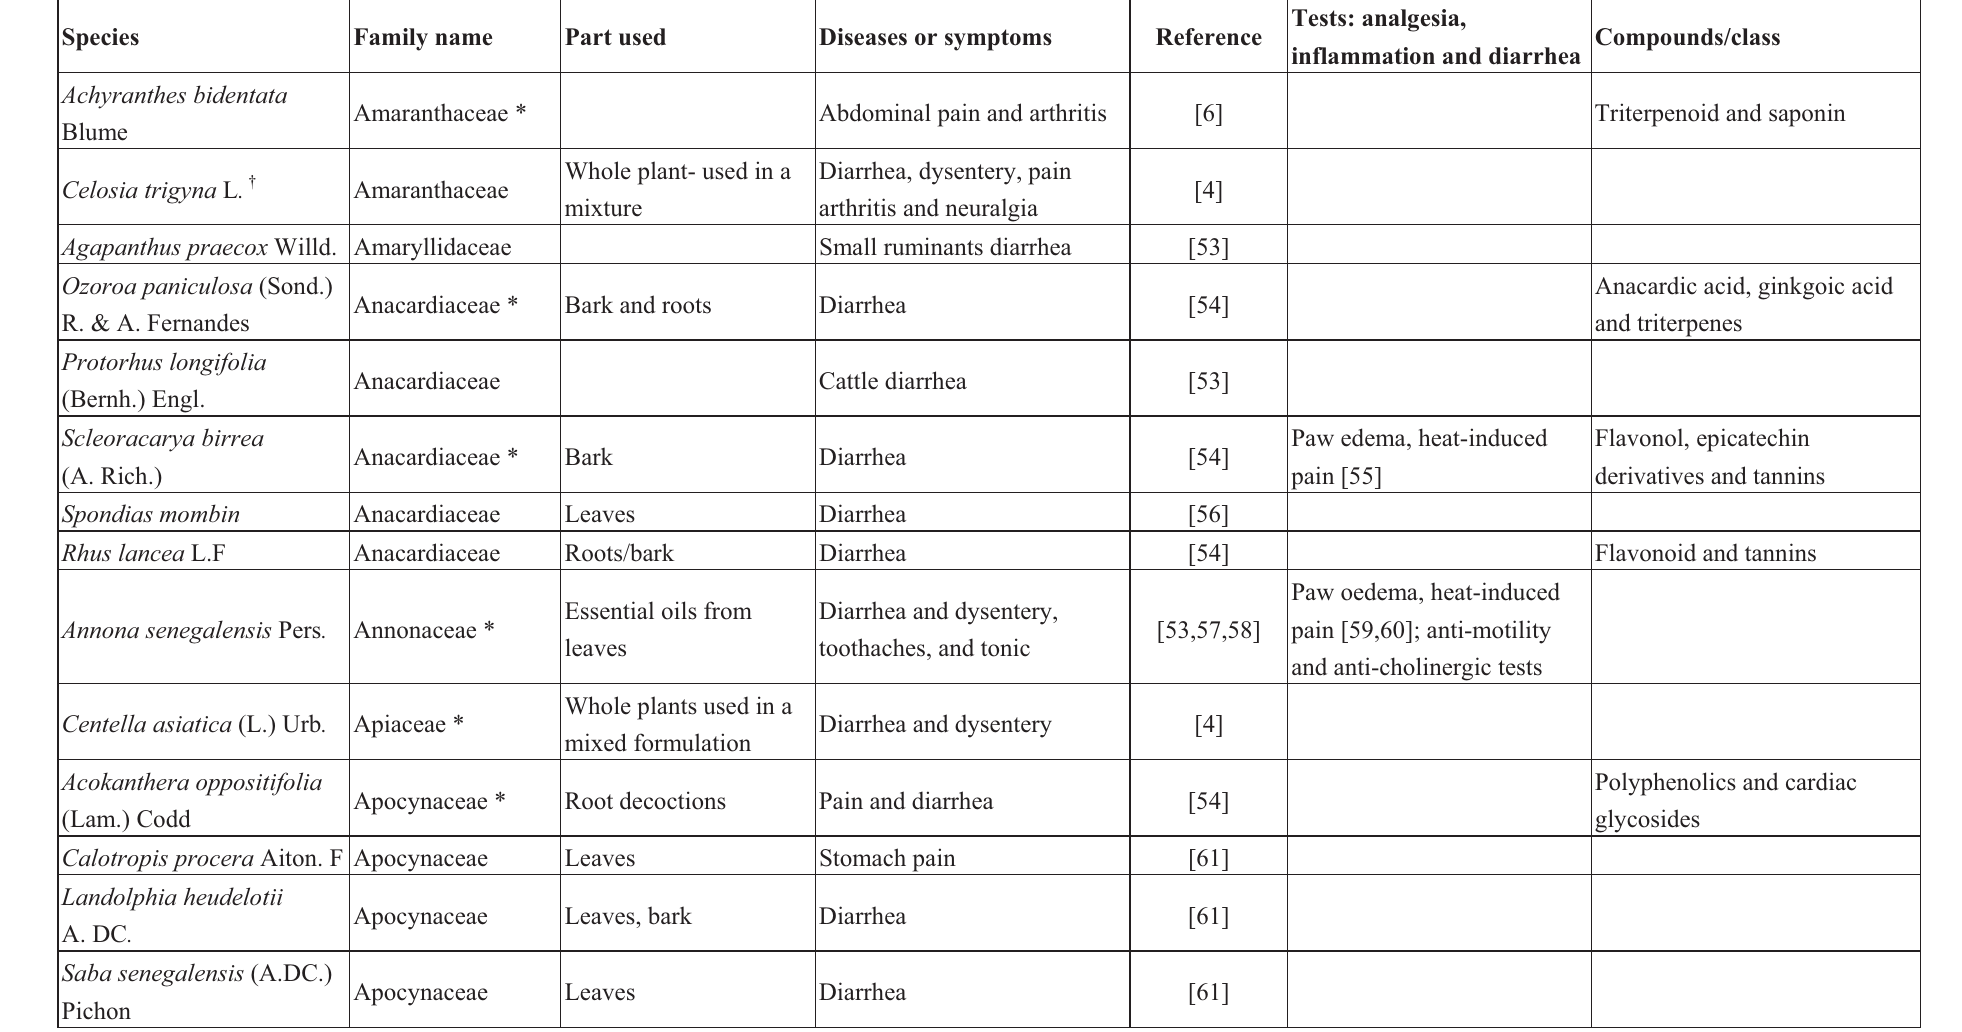
Table 1. Inventory of African herbal and plant therapies of animal pain and